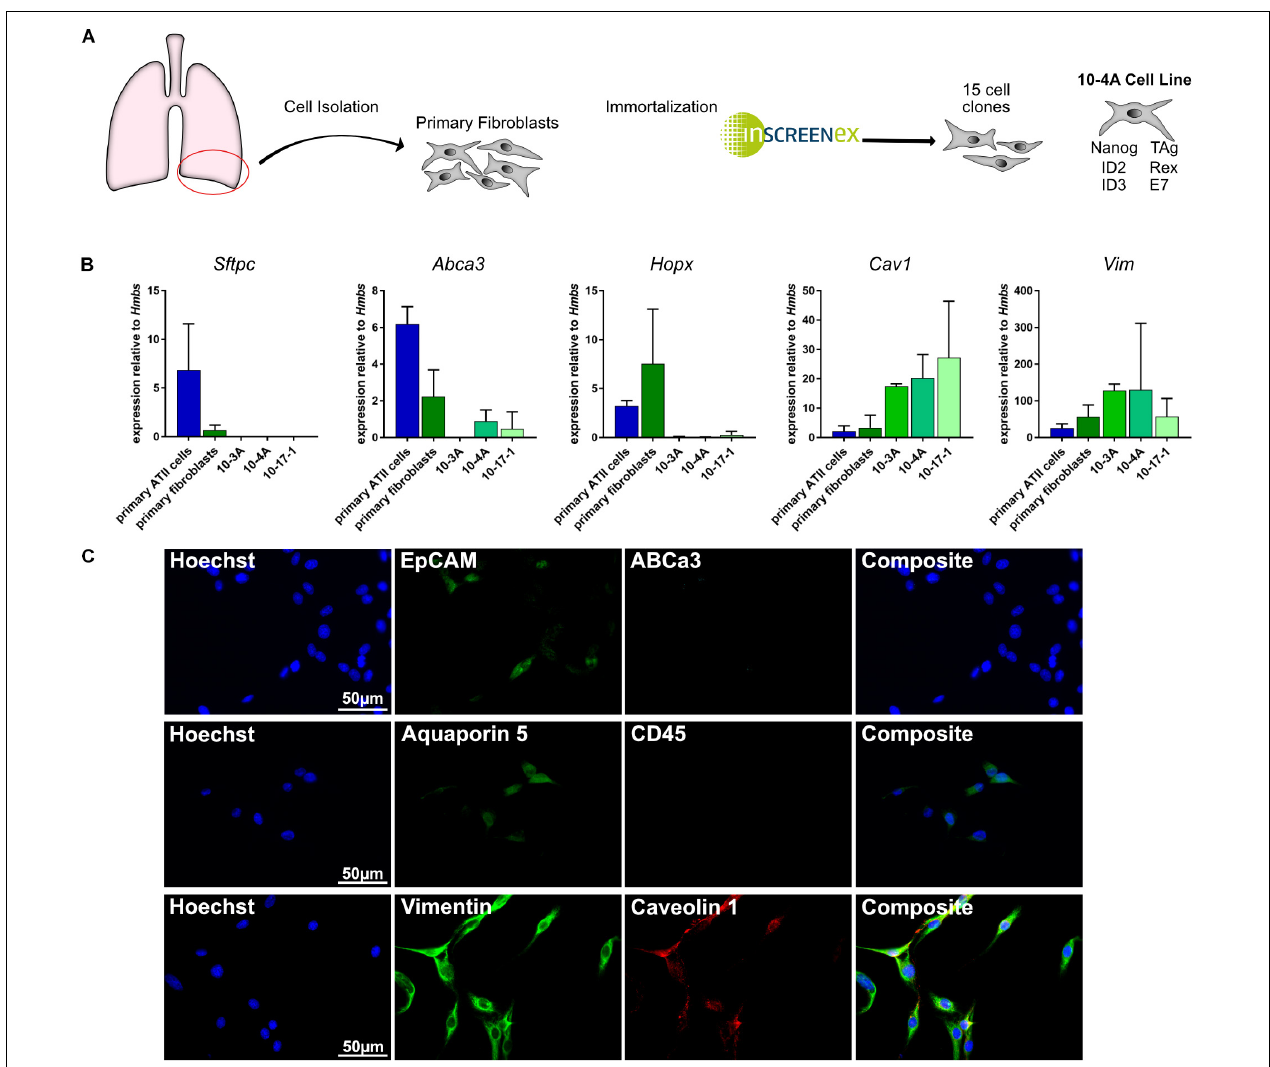
FIGURE 1 | Gene and protein expression pattern of the immortalized cell lines. (A) Schematic representation of the immortalization process. Right: Genes incorporated in 10-4A cells for immortalization (B) Semi-quantitative RT-PCR of ATII cell ( Sftpc , Abca3 ), ATI cell ( Hopx , Cav1 ), and mesenchymal cell ( Vim ) marker genes. N = 5 (C) Immunofluorescent staining of 10-4A cells for expression of epithelial cell (EpCAM), alveolar type II cell (ABCa3), alveolar type I cell (aquaporin 5, caveolin 1), leukocyte (CD45), and mesenchymal cell (vimentin) marker expression. 10-4A cells predominantly express mesenchymal marker vimentin and caveolin-1, that is also expressed in lung fibroblasts. Scale bar = 50 µ